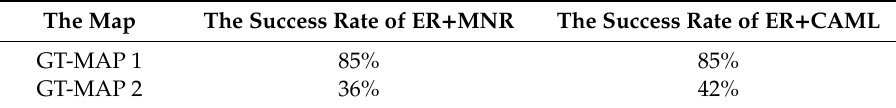
Table 3. Generalization test on new maps.